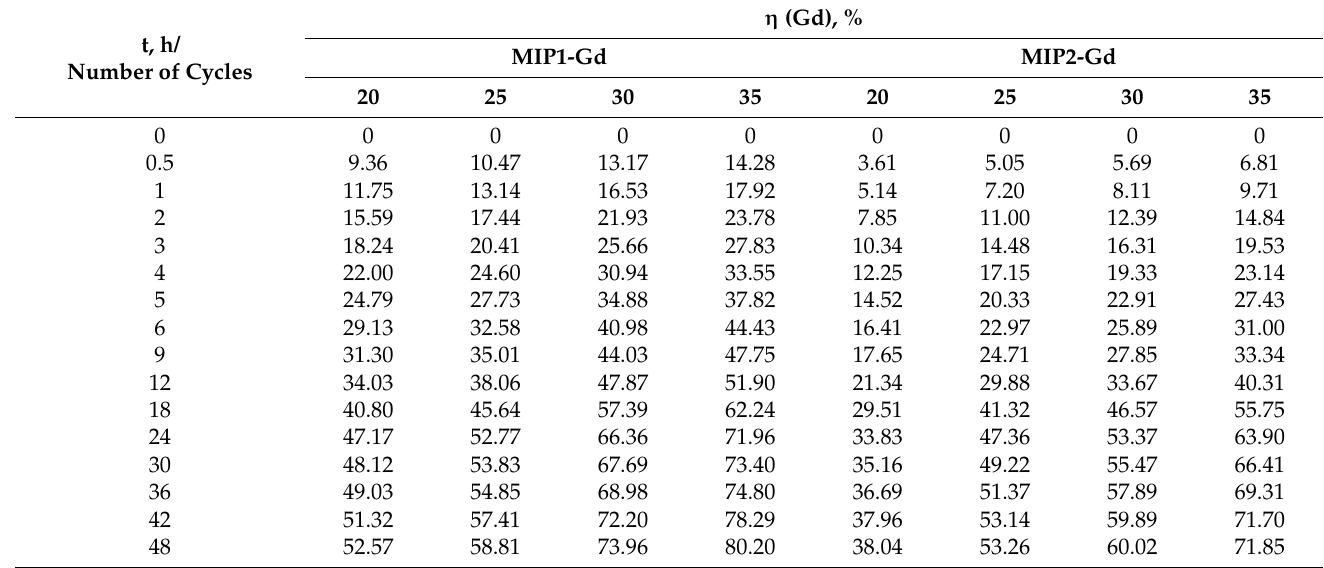
Table 6. Values of extraction degree of gadolinium after certain amount of template removal cycles.